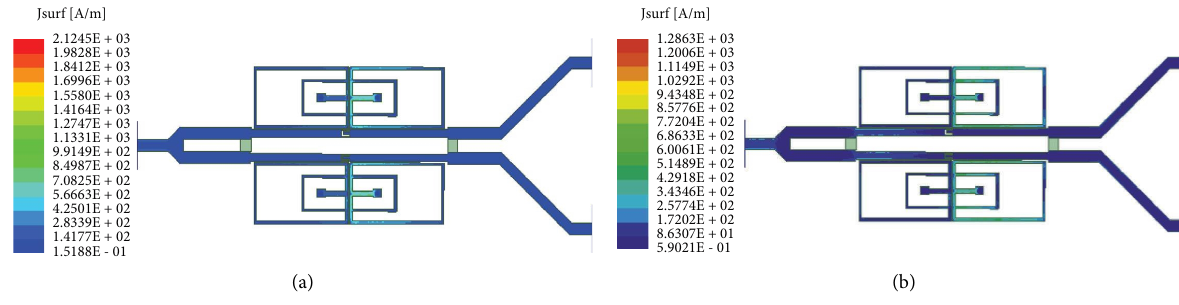
Figure 6: Current distribution of the resonator. (a) 2.45G. (b)